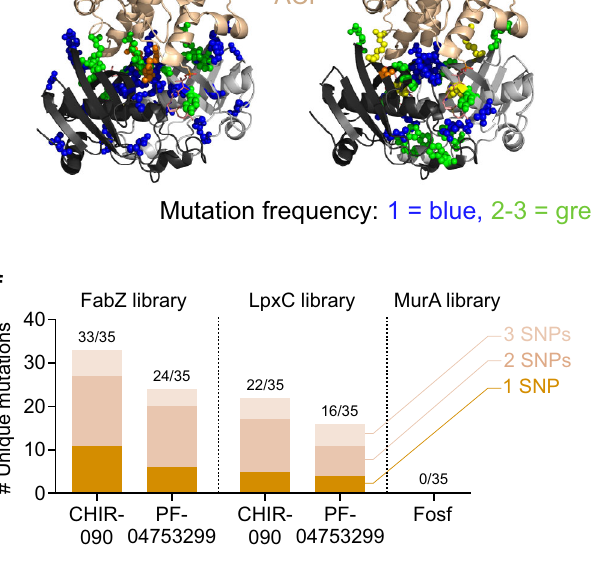
Fig. 7 | Saturation editing libraries can guide efforts for the development of novel antibiotics. a – c The frequency of occurrence of spontaneous resistance mutations is compared to the frequency of occurrence of resistant variants in the saturation editing libraries. This was done by plating either a wild-type culture or the different libraries onto medium containing different concentrations of the compound, i.e. 4x MIC ( a ), 8× MIC ( b ) or 32× MIC ( c ), and counting the number of colonies that developed after overnight growth. These numbers were normalized to the total cell numbers present in the wild-type culture or the libraries, respec- tively. d The location of targeted residues in the FabZ protein is shown for both CHIR-090 and PF-04753299. Residues are colored according to the number of times they were targeted in isolated resistant variants. Only one dimer of the FabZ hexamer is shown for clarity. Mutations are indicated in both chain A and B. e The